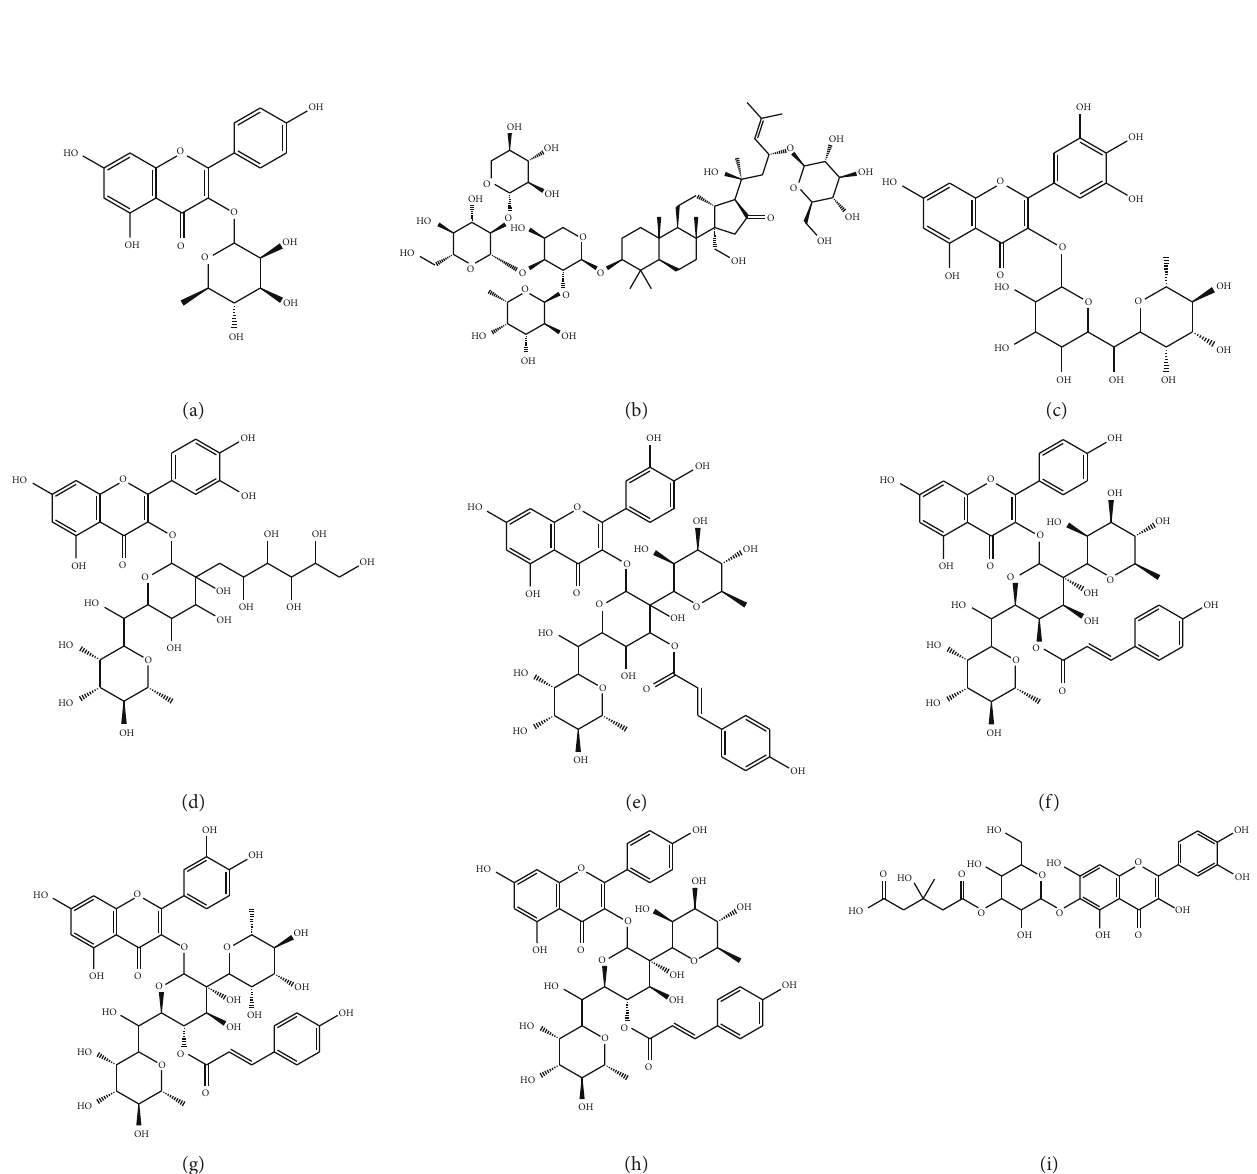
Figure 3: Some of the major compounds from Z. spina parts. (a) Kaempferol-3- O -rhamnoside. (b) Jujuboside B1. (c) Myricetin-3- O -(6- rhamnosyl) hexoside. (d) Quercetin-3- O -[(2-hexonyl)-6-rhamnosyl]-hexoside. (e) Quercetin-3-O-p-coumaroyl (2,6-dirhamnosyl)- hexoside. (f) Kaempferol-3- O -(4- O -(p)-coumaroyl)-2-rhamnosyl-[6-rhamnosyl]-galactoside. (g) Quercetin-3- O -(4- O - p -coumaroyl)-2- rhamnosyl-[6-rhamnosyl]-glucoside. (h) Kaempferol-3-O-(4-O-p-coumaroyl)-2-rhamnosyl-[6-rhamnosyl]-glucoside. (i) Quercetin 3-O-